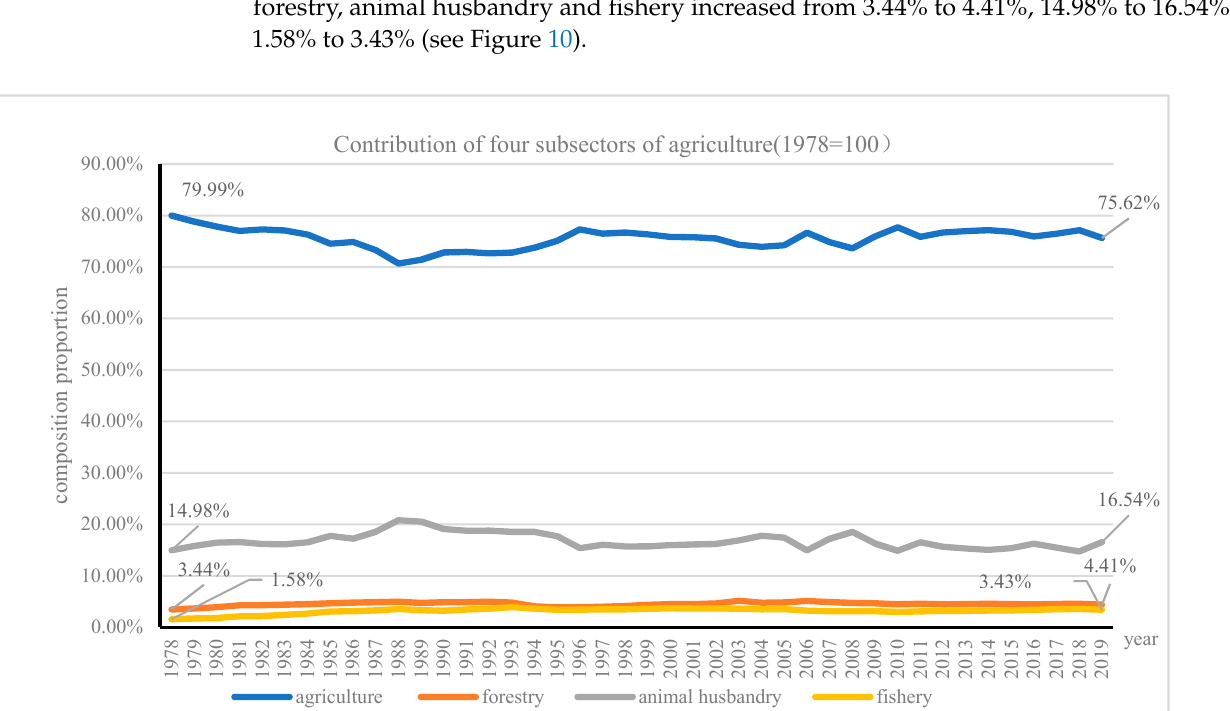
Figure 9. Development of broad agriculture in China.